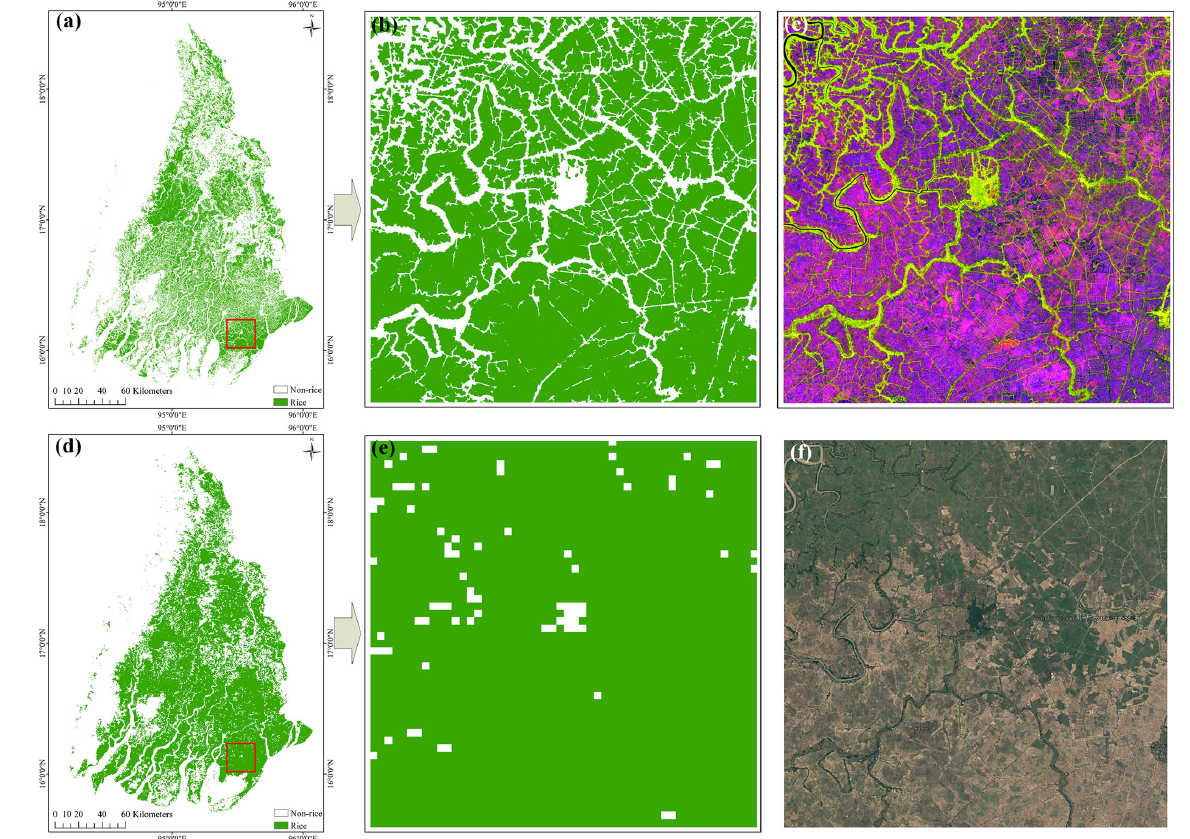
Figure 9. Comparison of our extracted rice area map of Ayeyarwady Province with IRRI data: (a) our rice area extraction result; (b) the enlarged view of the red box in panel (a) ; (c) the pseudo-color image of SAR features corresponding to panel (b) ; (d) IRRI rice data; (e) the enlarged view of the red box in panel (d) ; (f) the optical image (© Google Earth) corresponding to panel (e)